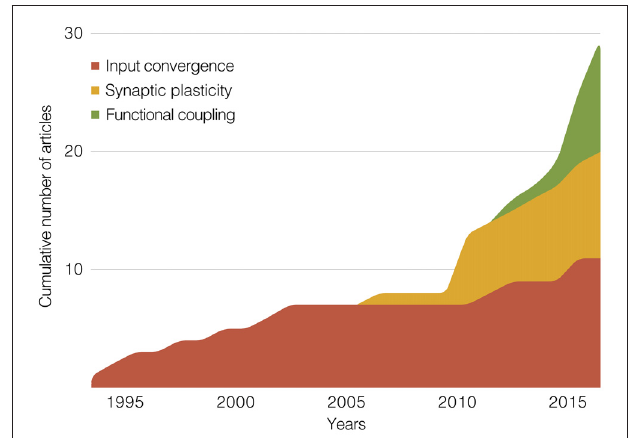
FIGURE 5 | Stacked area graph showing the cumulative number of publications within our scope. The graph depicts three methodological categories of studies that jointly manipulated/recorded hippocampal, prefrontal and thalamic sites. Summaries of these categories make up the main section of this review article: “Rodent Electrophysiology Studies.” The x -axis is divided in 1-year bins, from 1994 to